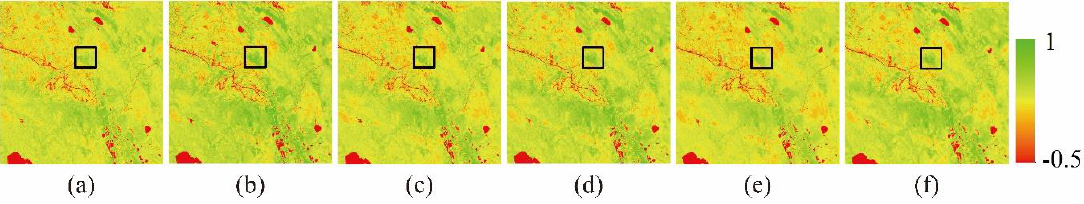
Figure 7. Visual comparison of the forest area. ( a , b ). Original Landsat_NDVI on 12 August and 11 July 2001; ( c – f ). Predicted Landsat_NDVI by ESTARFM, NDVI-LMGM, FSDAF and NDVI_FMHC.